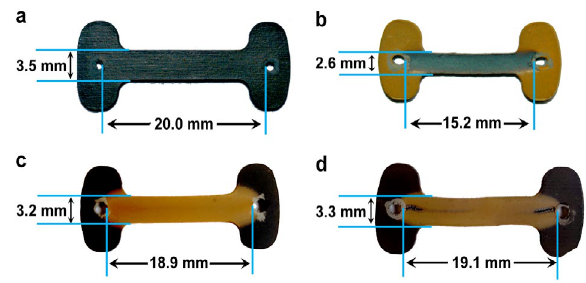
Fig. 1 Optical view of dog bone-shaped samples (a) after uniaxial cold-pressing (at 280 MPa) of the initial precursor heat treated at 400 ℃ for 2 h, (b) after sintering under an applied field of 30 V·cm − 1 , (c) showing a homogeneous body after flash under 160 V·cm − 1 at J = 22.0 mA·mm − 2 , and (d) with channelling-like physical damage after flash under 160 V·cm − 1 now at J = 25.0 mA·mm − 2 . The black-like colour in (a), (c), and (d) comes from presence of residual organic compounds, turning to be yellowgreen-like in (a) to (d) after removal. As normally expected, the sample in (b) was gray-like towards the sintered dog bone gage